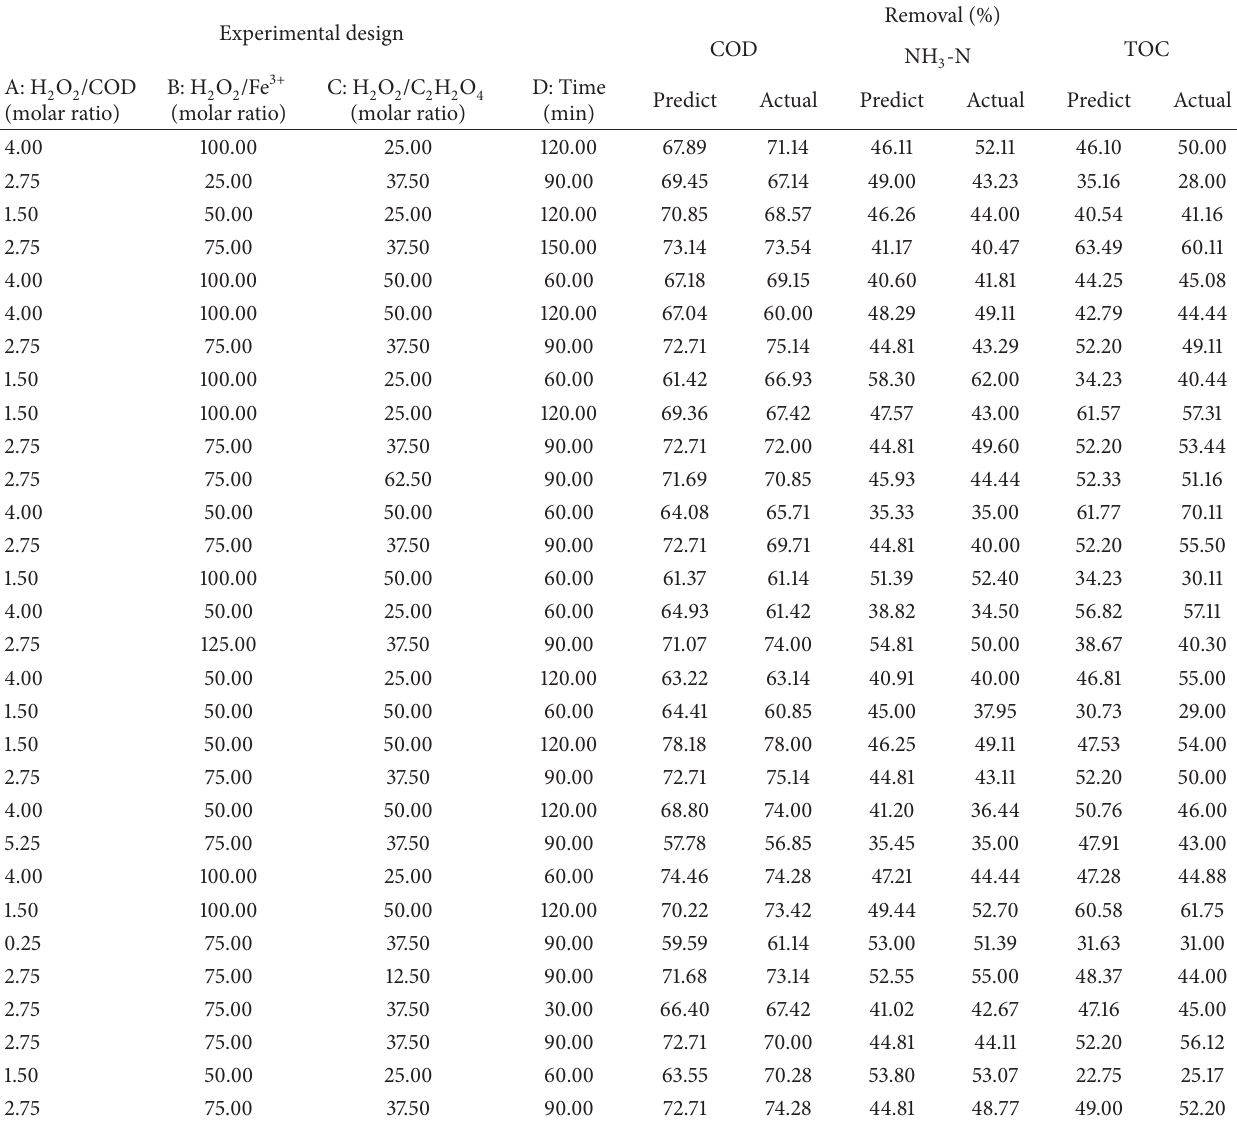
Table 1: Experimental design and predicted and actual